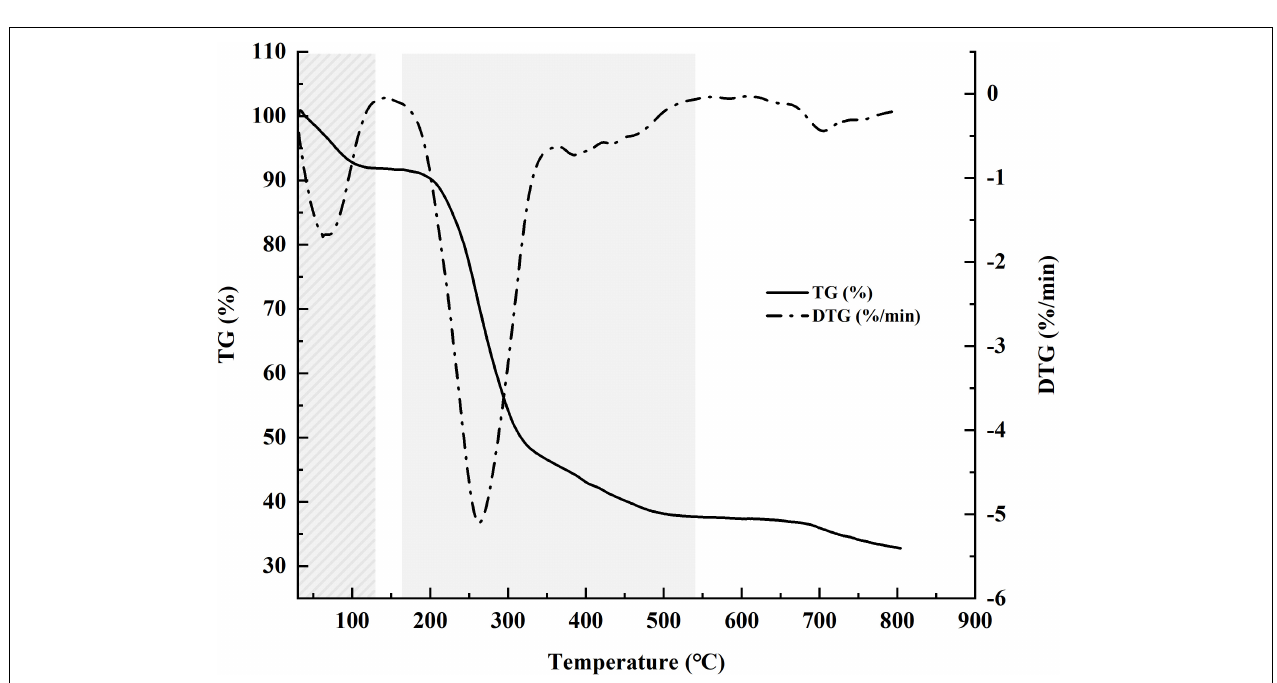
FIGURE 5 | Weight loss (TG) percentage and derivative thermogravimetric (DTG) curves for Heimioporus retisporus Polysaccharide (HRP).